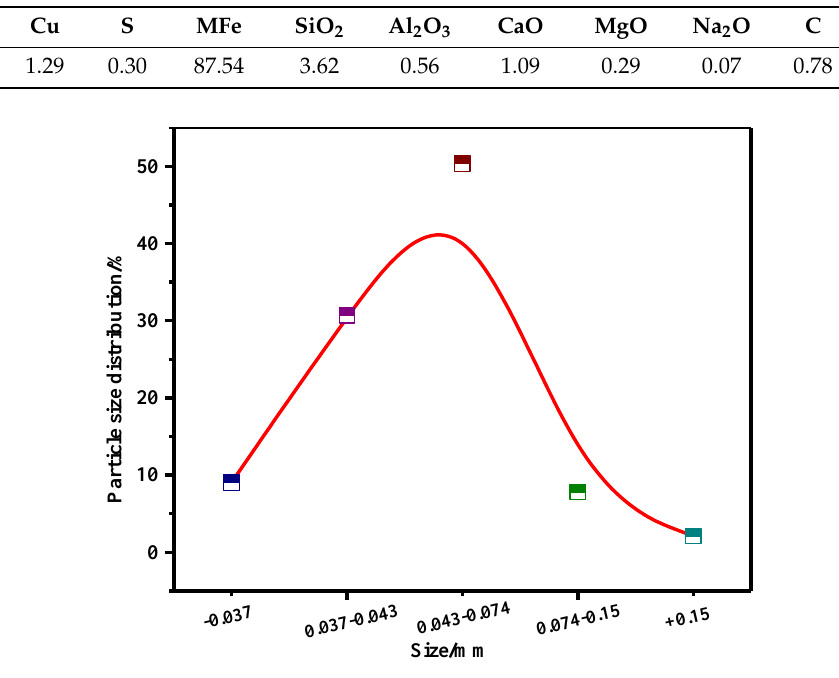
Figure 1. Size distribution of CBDRI.